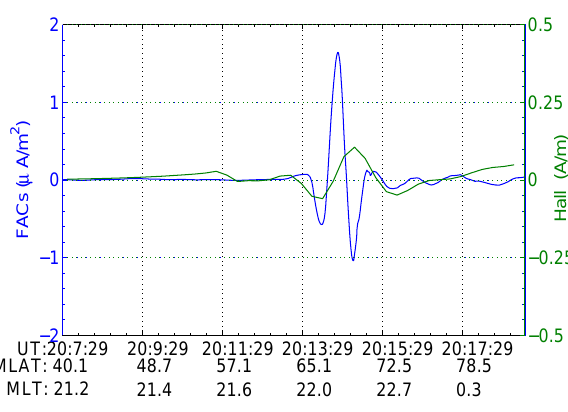
Fig. 4. Ionospheric currents observed by CHAMP at the time of the auroral breakup. Positive FACs (blue lines) are directed upward, positive Hall currents (green lines) flow